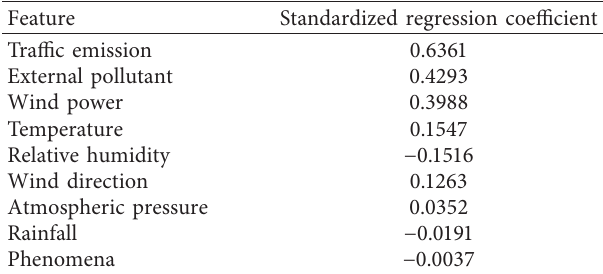
Table 8: Standardized regression coefficient of the